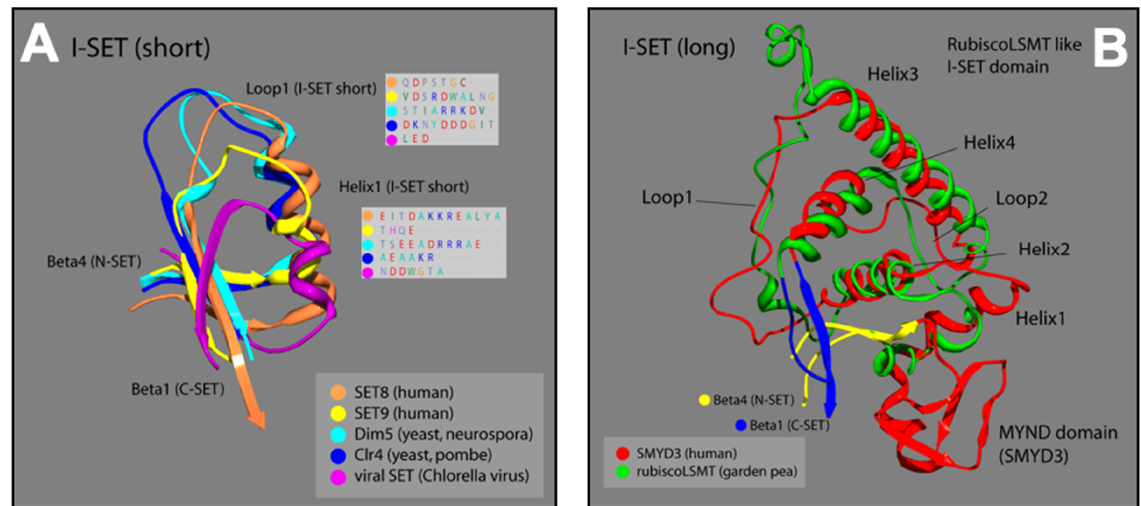
Figure 4. Ribbon models of I-SET regions from multiple SET-domain proteins; colors correspond to labels in key for each ribbon strand. ( A ) Loop1 and Helix1 boxes are predicted protein sequences corresponding to the location of Loop1 and Helix1 of I-SET [16,17]. ( B ) Plant and animal comparison with corresponding colors. Overlay of SMYD3 and garden pea I-SET domains. Distinctive homoloy illustrated in the helix and loop patterns